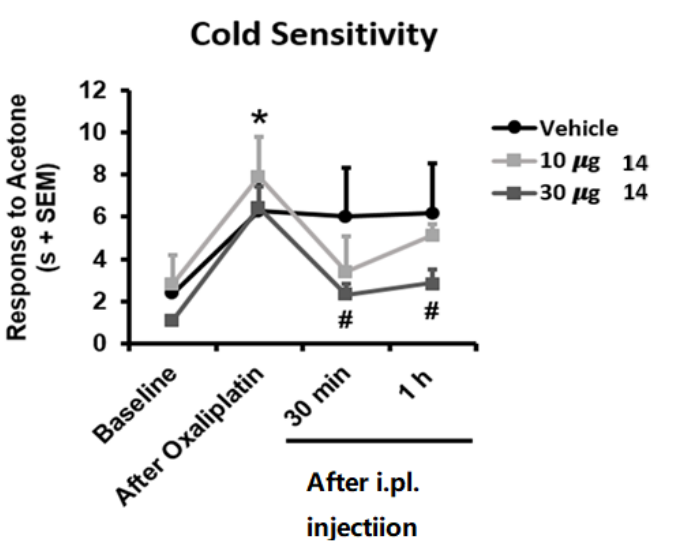
Figure 7. Reduced oxaliplatin (OXP)-induced cold allodynia by TRPM8 blocker 14 ( BB 0322703 ). Mice were treated with three i.p. injections of OXP (6 mg/kg) or the vehicle (VH) on alternate days and on day 7 the cold allodynia behaviour was evaluated by the acetone test, before (baseline) and after OXP treatment. Time course effect of the TRPM8 blocker at 10 or 30 µ g. Data are given as mean ± SEM ( n = 6). one-way ANOVA with Tukey post hoc test. * p < 0.05 OXA vs. baseline. # p < 0.05 OXP vs. 30 µ g 14 ( BB 0322703